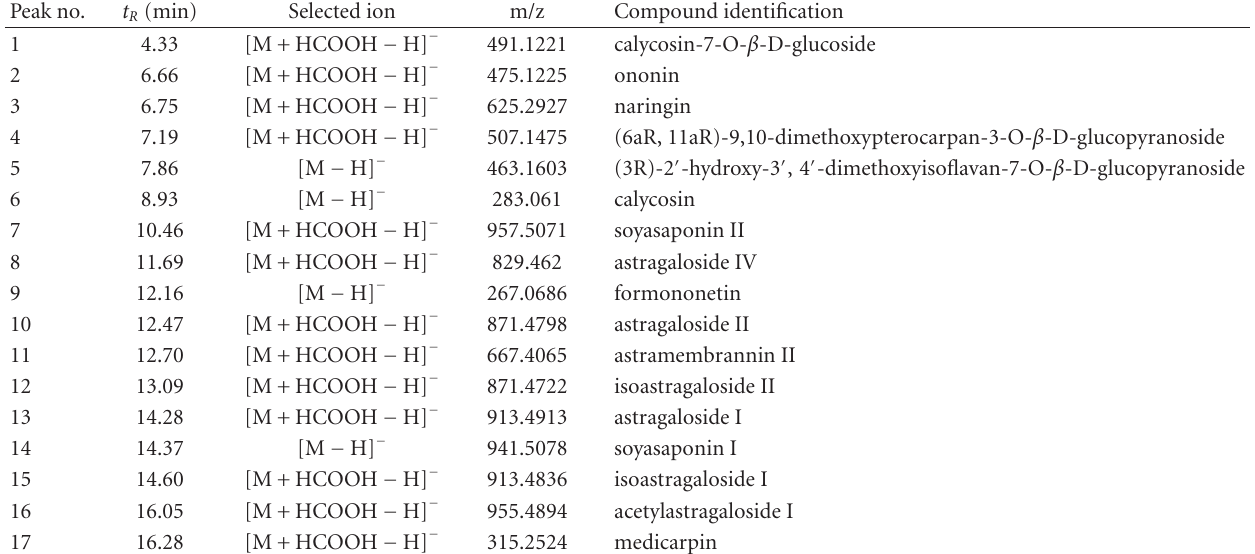
Table 2: Accurate mass measurements of the compounds in MGHQ, MJHQ, and HQ as revealed by UPLC/TOF-MS analysis in negative mode.